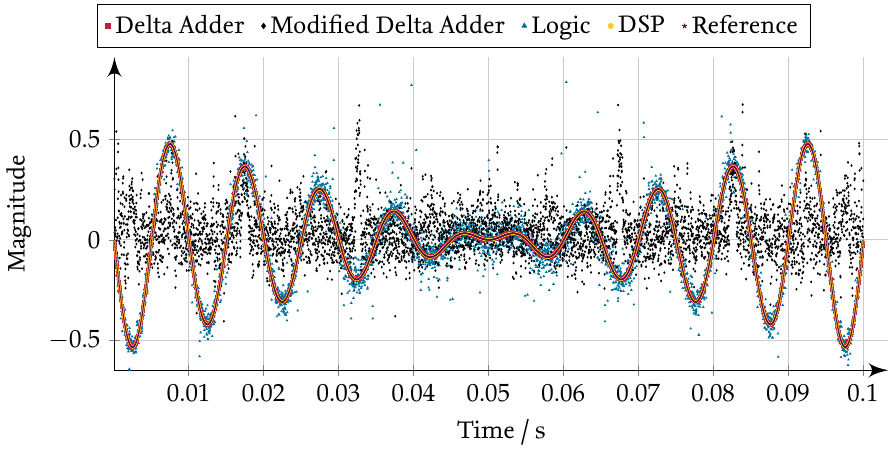
Figure 31. Sinc 3 filtered results for the multiplication with a decimation rate of